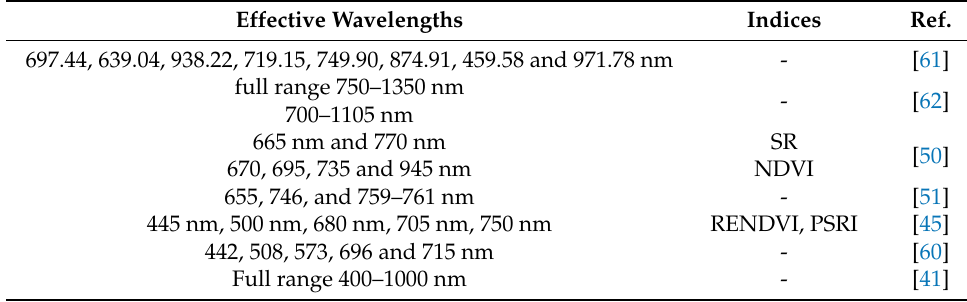
Table 2. Effective wavelengths for disease